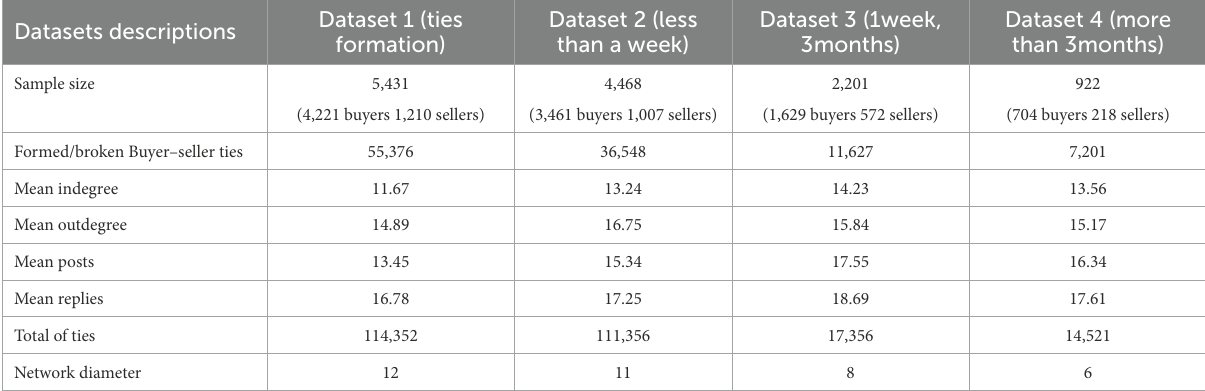
TABLE 2 Descriptives of datasets in ties formation versus persistence